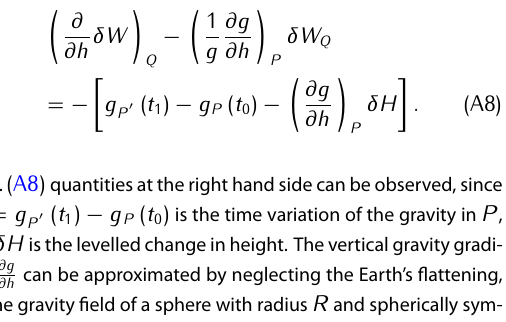
Fig. 2. Temporal variation of geoid undulation difference at